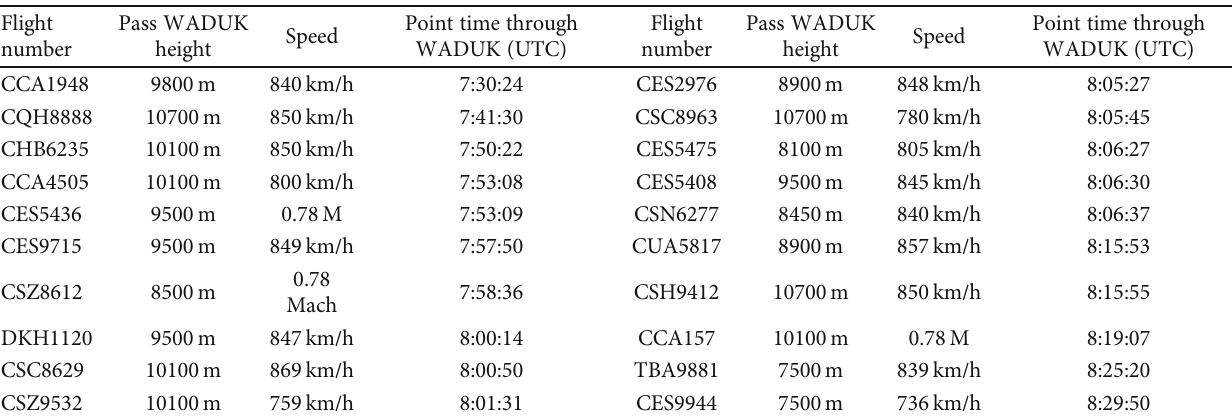
Figure 6: Comparison between real-time trajectory pro fi le and trajectory prediction pro fi le. Table 2: Based on the fl ight plan, the fl ow of fl ights passing through WADUK point in the same time